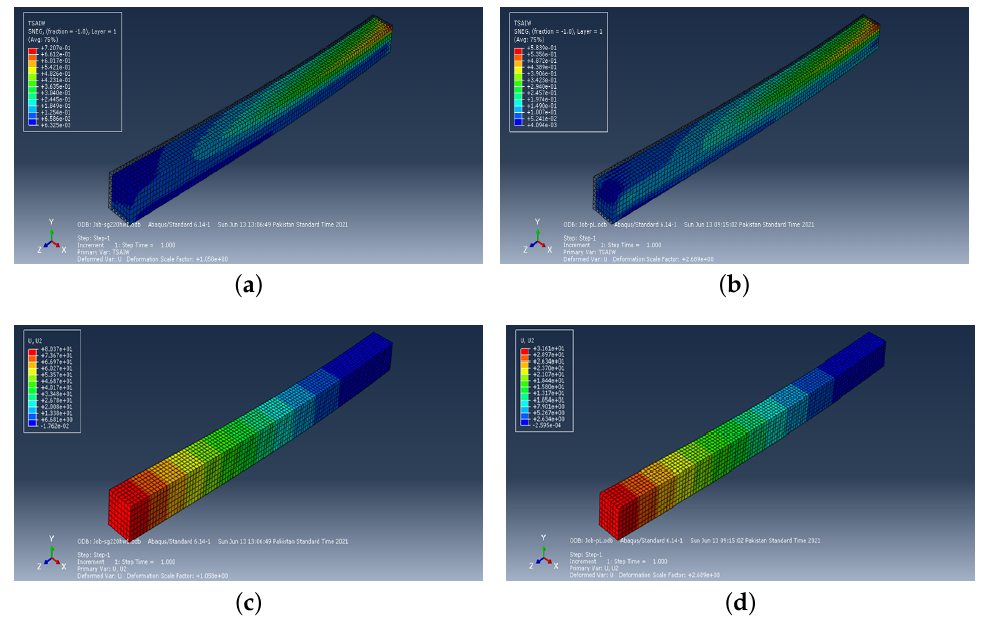
Figure 7. Results of Tsai-Wu failure criterion and deflection for straight main landing gear struts. ( a ) Results of Tsai-Wu failure criterion for straight main landing gear strut composed of S-glass fiber/epoxy (Model 6). ( b ) Results of Tsai-Wu failure criterion for straight main landing gear strut composed of T300 carbon fiber/epoxy (Model 3). ( c ) Results of deflection for straight main landing gear strut composed of S-glass fiber/epoxy (Model 6). ( d ) Results of deflection for straight main landing gear strut composed of T300 carbon fiber/epoxy (Model